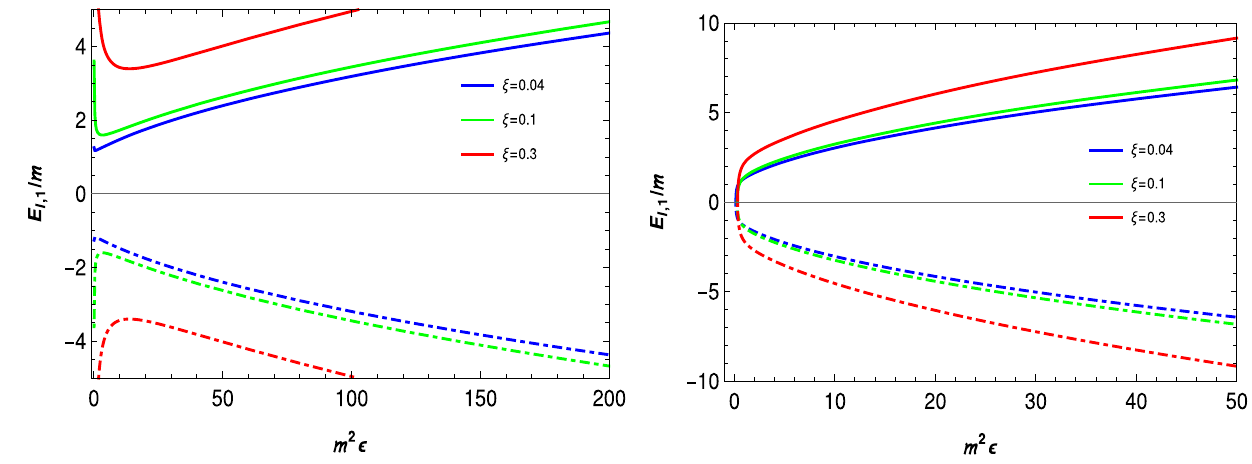
| as a function of m 2 (cid:4) . Fig. 5 In both figures we are visualizing | E l , 1 positive sign of the energy spectrum Eq. (35) and the dotted curves the m In the figure on the left, we fixed the parameter α = 0 . 1 and varied negative sign. On the curve on the right, we fix the parameter α = 0 . 3 some values for the parameter ξ . The continuous curves represent the and vary the parameter ξ . In both cases, we set ω/ m = l = 1